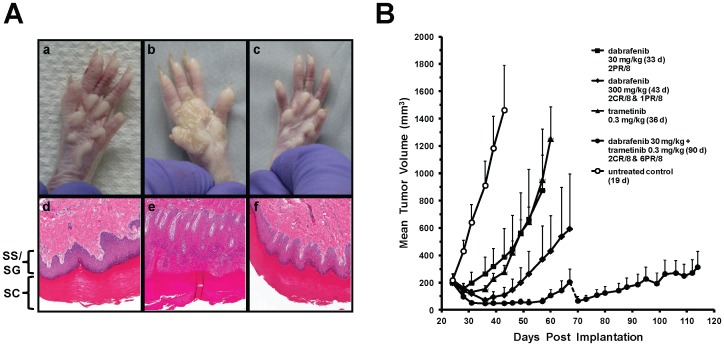
BRAF and MEK inhibitor combination decreases rat skin lesion formation and increases tumor growth inhibition.Macroscopic and light microscopic photographs of skin (ventral forepaw) from rats given vehicle (a/d), 150 mg/kg/d BRAF tool inhibitor (b/e), or 150 mg/kg/d BRAF tool inhibitor with 0.75 mg/kg/d MEK tool inhibitor (c/f) by oral gavage for 12 consecutive days (A). Stratum spinosum/stratum granulosum (epithelial layer, SS/SG) and stratum corneum (keratin layer, SC) are indicated. Mice bearing A375P tumors were treated orally, once daily, with the indicated doses of dabrafenib, trametinib, or a combination of both agents (B). Treatment continued until the mean tumor volume of each group reached 1 200 mm3 or one death occurred. Mean tumor volumes are plotted with their standard error mean and complete (CR) or partial (PR) regressions are indicated for each group of n = 8 mice after 14 days of treatment. The dotted line for the combination group indicates where one animal was euthanized due to tumor necrosis.